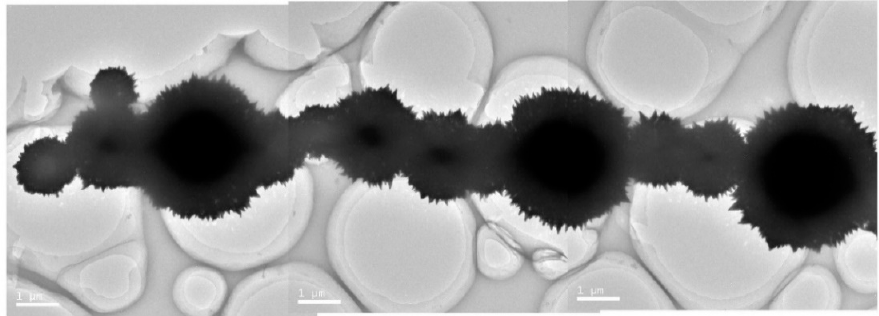
Figure 8. TEM image of an Ni microsphere chain formed in the presence of 3 mL of EDA in 50 mL of 15 M NaOH solution. Reaction duration is 6 h.